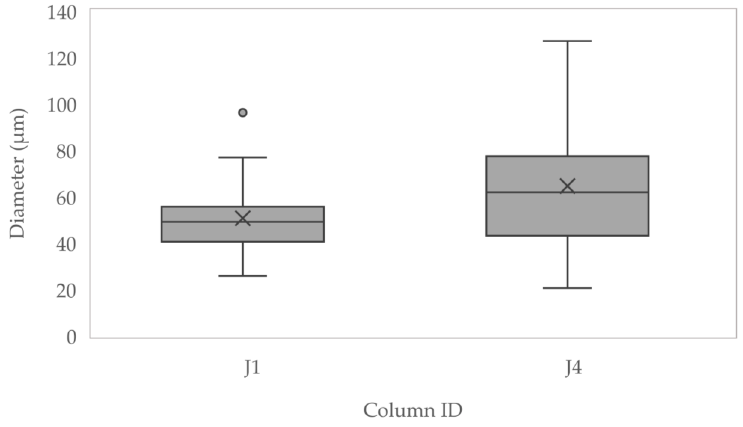
Figure 14. Diameters of jute fibres measured using scanning electron microscopy (SEM).